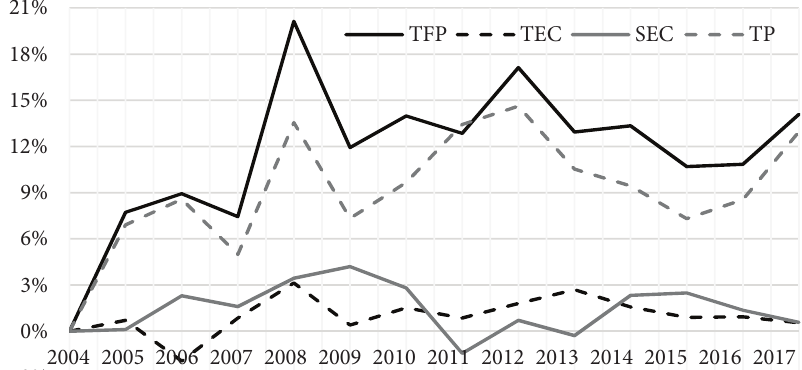
Figure 1. Cumulative TFP and its